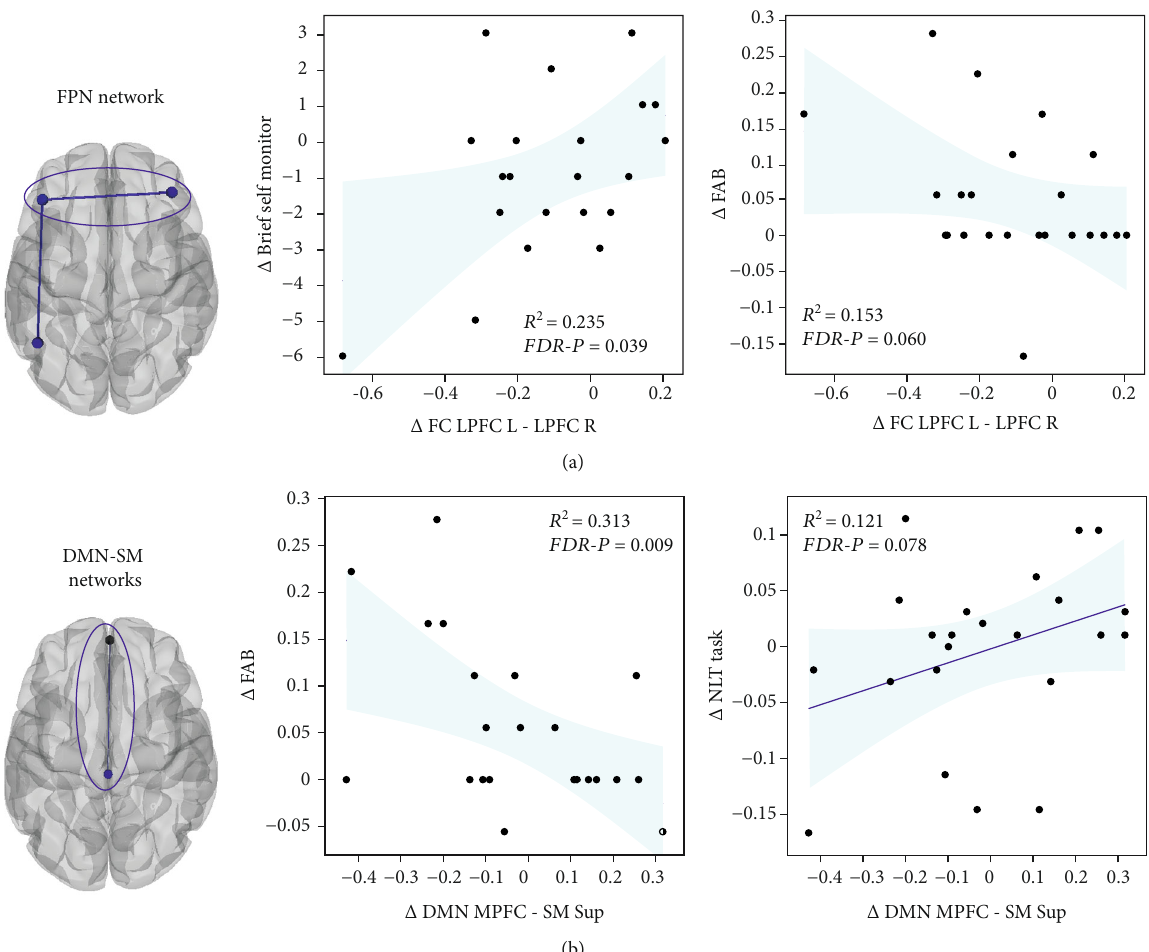
Figure 3: Within- and between-network functional connectivity changes associated with cognitive recovery induced by the neurological music therapy intervention. (a) The behavior and functional connectivity values are derived from the pre-post intervention comparison, which was signi fi cant for the within-network connectivity changes in the FPN. (b) The behavior and functional connectivity values are derived from the AB > BA and TP2 > TP1 interaction, which was signi fi cant for the network connectivity changes between the DMN and SM network. The scatter plots represent the bivariate Pearson correlation and shaded areas represent the 95% CI prediction bounds. FPN: frontoparietal; DMN: default mode network; SM: sensorimotor; MPFC: medial prefrontal cortex; LPFC: lateral prefrontal